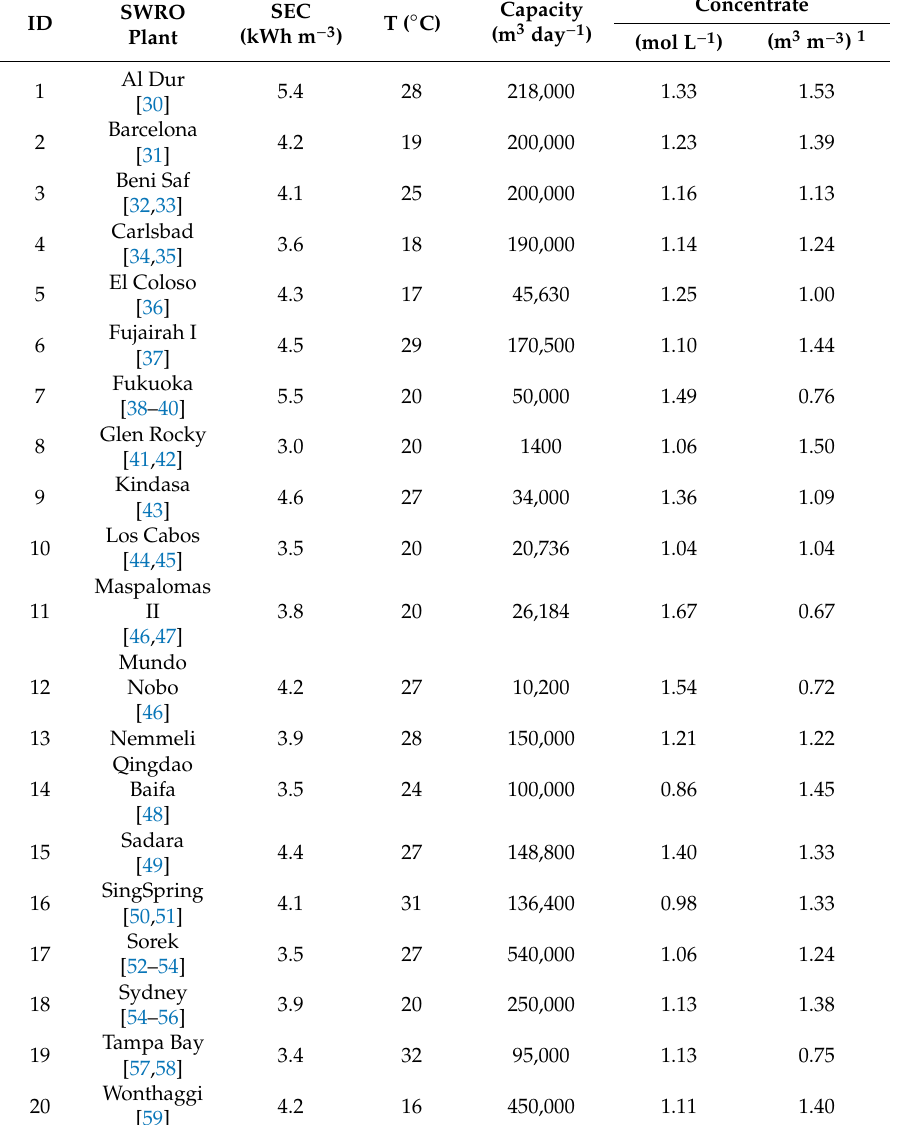
Table 1. Scenarios for RED implementation: Specifications of seawater reverse osmosis (SWRO) desalination plants. Data from